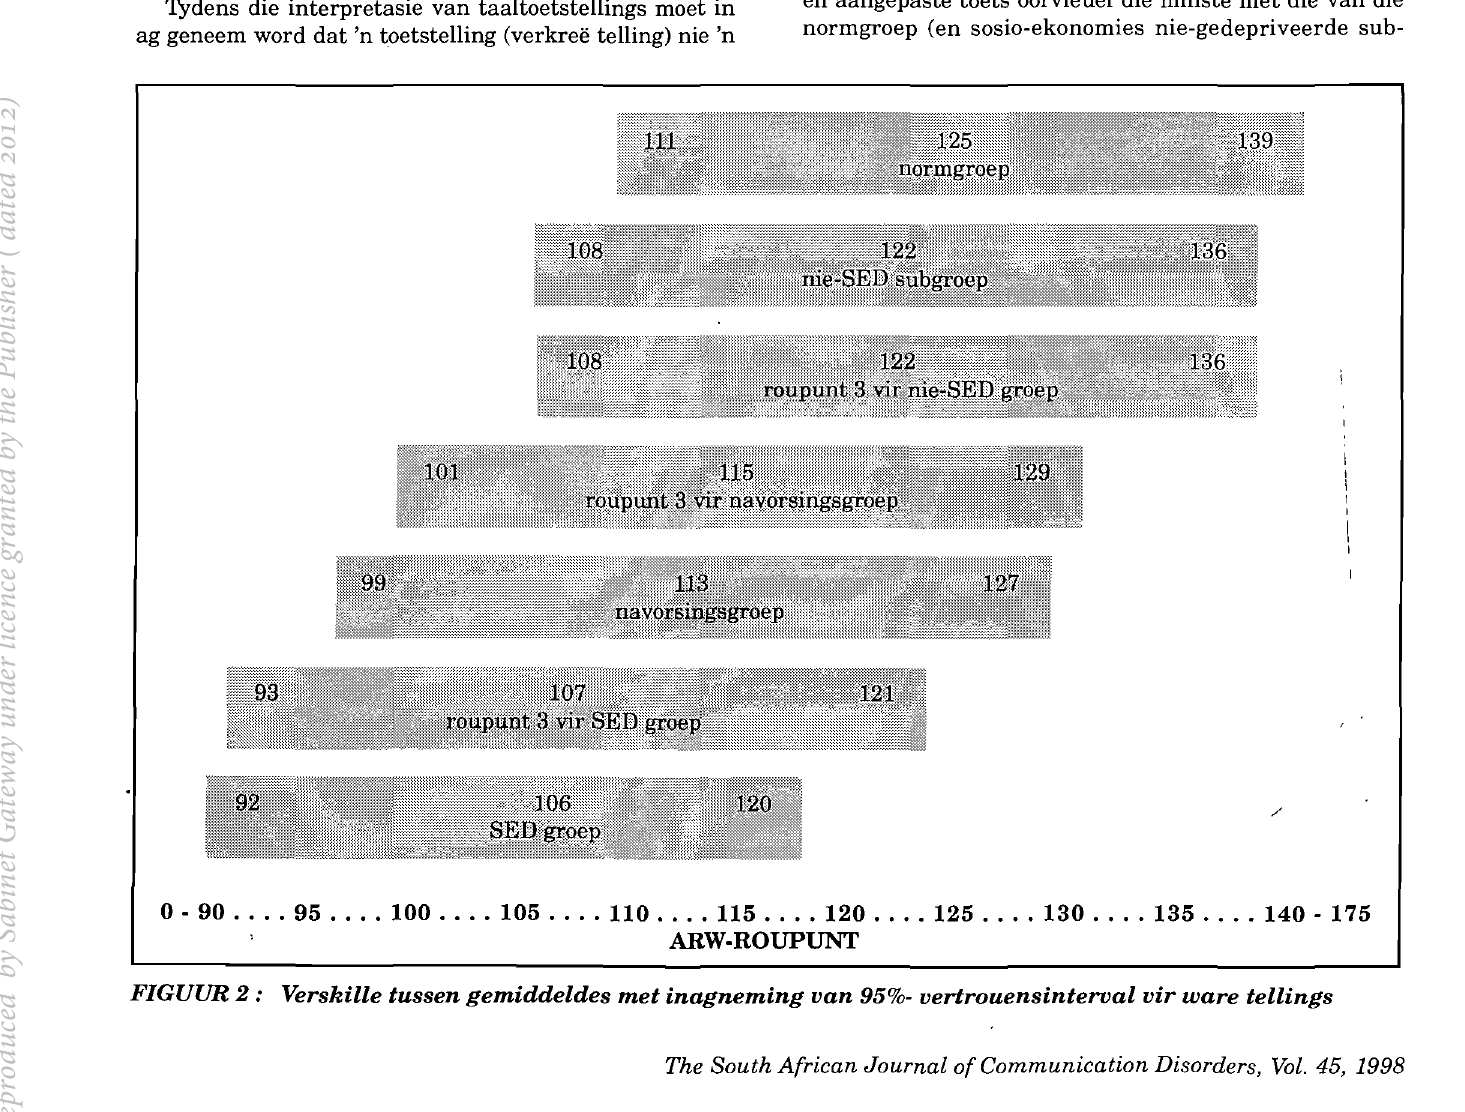
volgens vertrouensintervalle van ware tellings